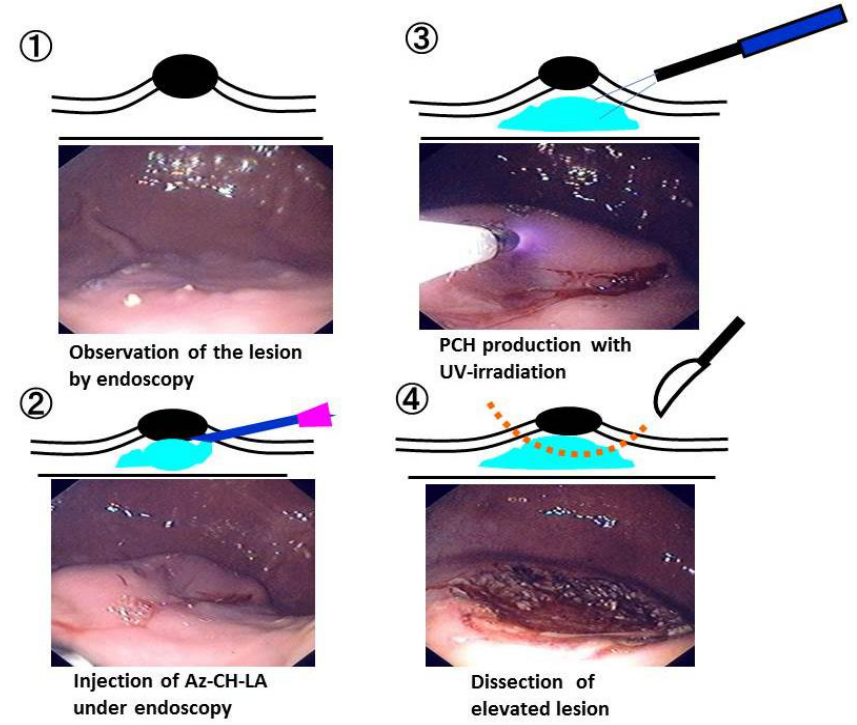
Figure 2. Representative images of Az-CH-LA injection, ultraviolet (UV) irradiation, and the